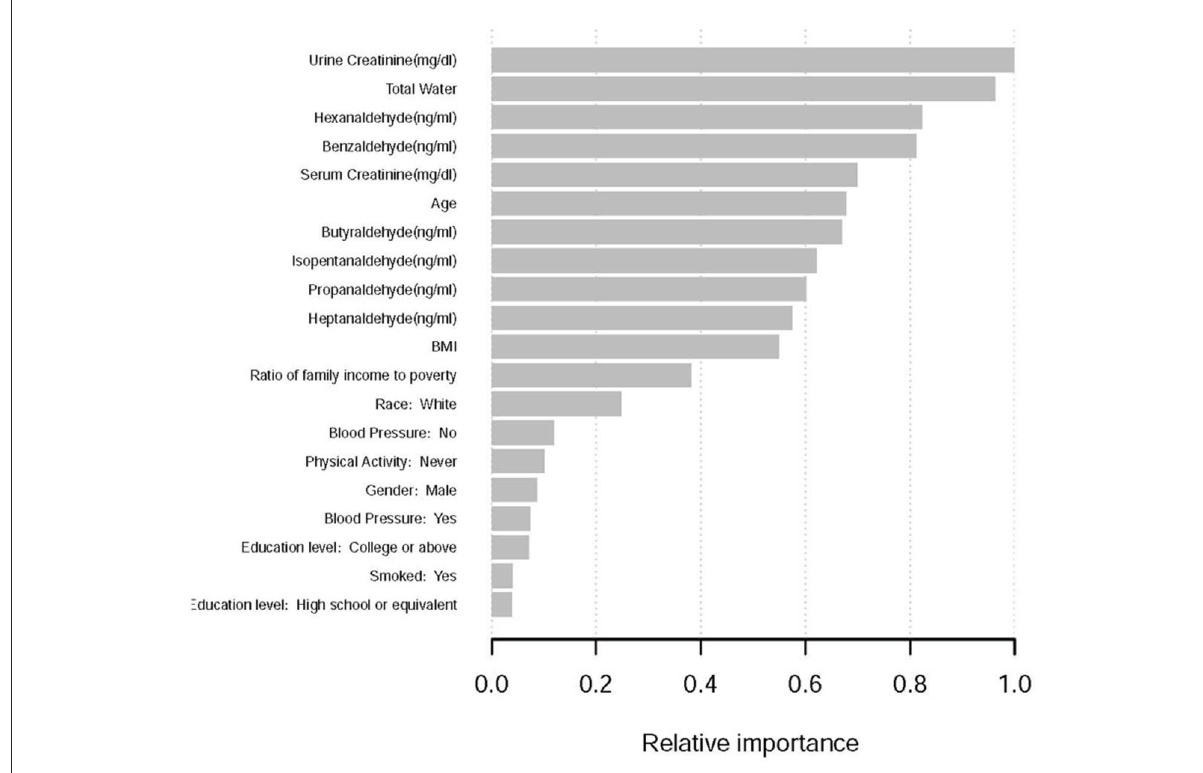
FIGURE1 Importance of the variables in the machine learning model, scaled to a maximum of 1.